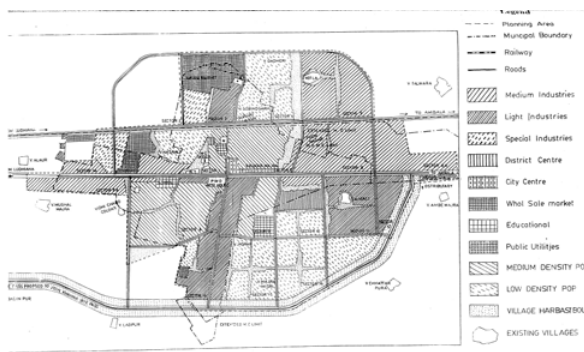
Figure 1: A guideline map of Mandi-Gobindgarh indicating the sampling sites Population Sample A sample of population from an industrial town and a non-industrial town were selected. A cross-sectional